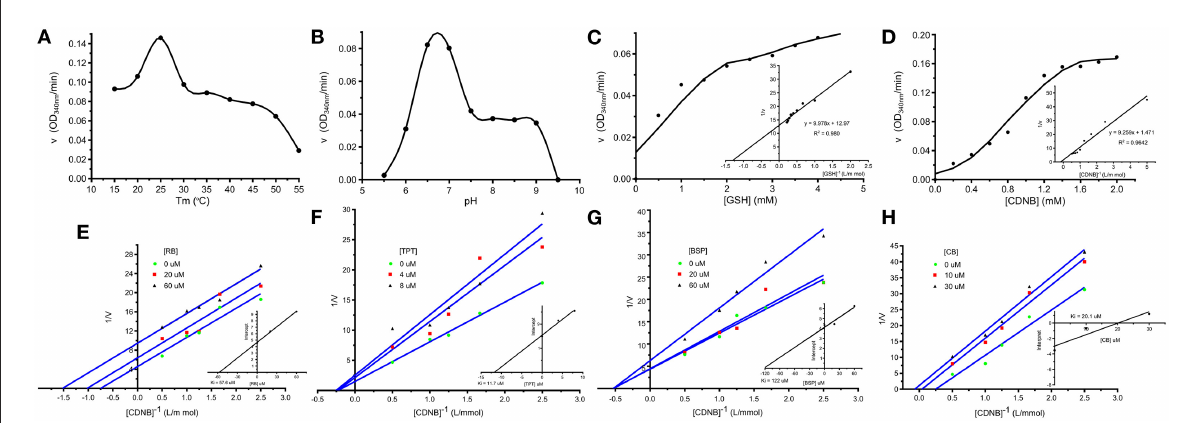
FIGURE4 Enzymatic characteristics of SmGST. (A) Effects of temperature on rSmGST enzymatic activity. (B) Effects of pH on rSmGST enzymatic activity. (C) Effects of substrate concentration of GSH on rSmGST enzymatic activity. The kinetic parameters, K m and V max , were determined using the Lineweaver–Burk’s plot. The K m and V max values were 0.78mM and 1.146 µ mol min − 1 mL − 1 , respectively. (D) Effects of substrate concentration of CDNB on rSmGST enzymatic activity. The K m and V max values were 6.29mM and 10.120 µ mol min − 1 mL − 1 , respectively. (E) The effect of different concentrations of Rose Bengal (RB) on the initial velocities. (F) The effect of different concentrations of Tripheniltin chloride (TPT) on the initial velocities. (G) The effect of different concentrations of Bromosulfophtalein (BSP) on the initial velocities. (H) The effect of different concentrations of Cibacron Blue (CB) on the initial velocities. Inset shows secondary plot of the 1/ V max values derived from the primary Lineweaver–Burk plot vs. concentration for the determination of K i . (E) RB (20, 60 µ M); (F) TPT (4, 8 µ M); (G) BSP (20, 60 µ M); (H) CB (10, 30 µ M).